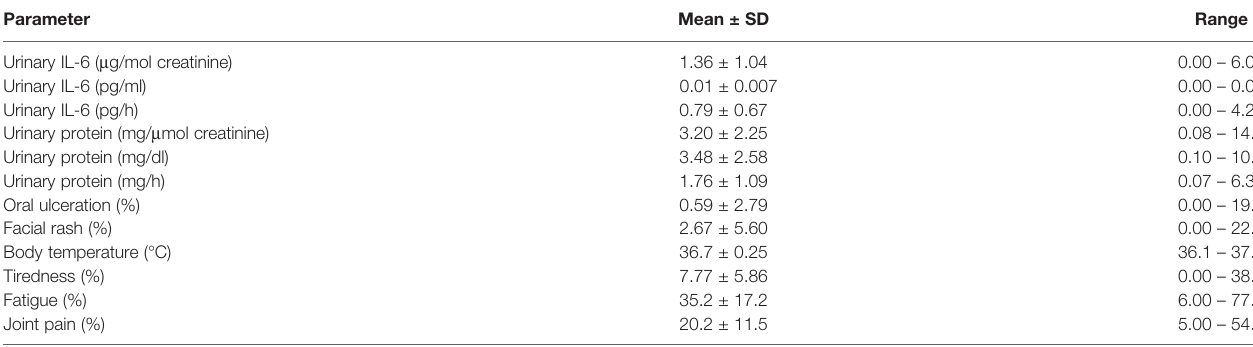
TABLE 1 | Descriptive statistics of urinary IL-6 concentrations and SLE-speci fi c and SLE-nonspeci fi c symptoms (N=112 consecutive measurements).